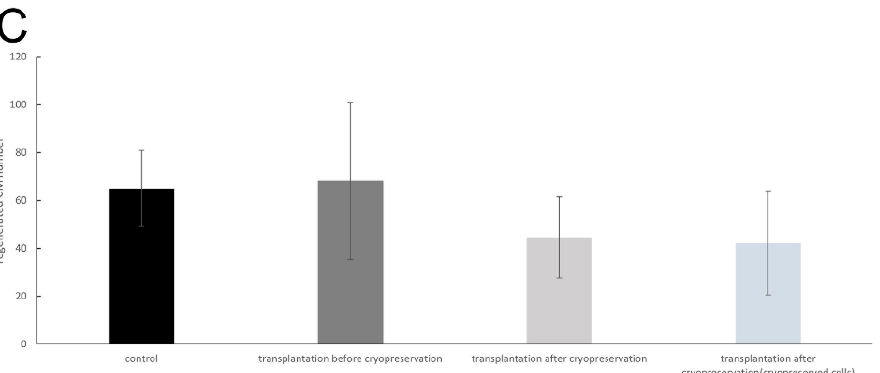
Figure 3. In vitro regeneration of nephrons at different cryopreservation timings. ( A ) Organ culture of E14.5 Six2-GCE+/diphtheria toxin fragment A+ mouse metanephroi. Mouse green fluorescent protein (GFP) renal progenitor cells were injected into the metanephroi before or after cryopreservation. Cryopreserved GFP renal progenitor cells were also used when the metanephroi were injected after cryopreservation. ( B ) Immunostaining of the metanephroi in ( A ). Regardless of the cryopreservation timing, the transplanted cells engrafted and differentiated at the ureteric tip to form the cap mesenchyme (CM) (scale bar, 400 μ m). ( C ) Measurement of transplanted cell-derived CMs. Error bars in bar plots represent standard errors of the mean. DAPI, 4 ′ 6-diamidino-2-phenylindole; CK8, cytokeratin 8.